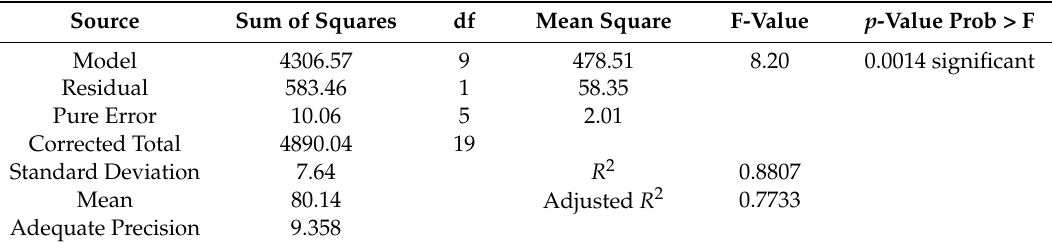
Table 3. ANOVA results for the trimethoprim degradation model; df—degrees of